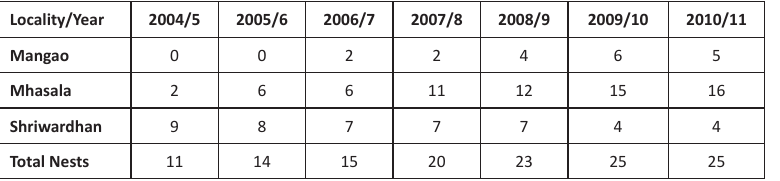
Table 2. Locality-wise and year-wise nest count during the study